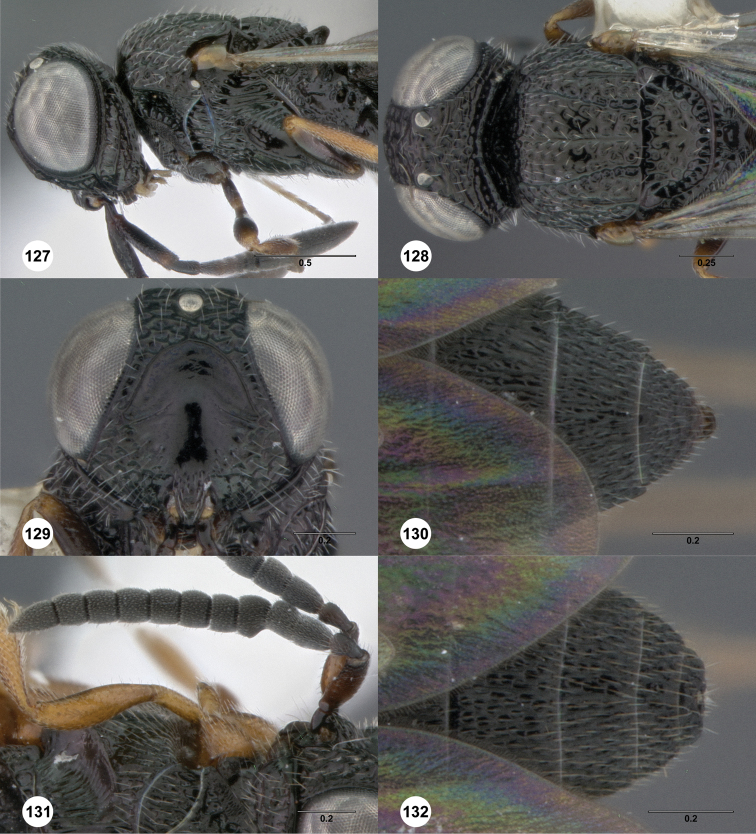
Oxyscelio gressus sp. n., holotype female (OSUC 456176) 127 Head and mesosoma, lateral view 128 Head and mesosoma, dorsal view 129 Head, anterior view 130 Metasoma, dorsal view. Paratype male (OSUC 456178) 131 Antenna 132 Metasoma, dorsal view. Morphbank52